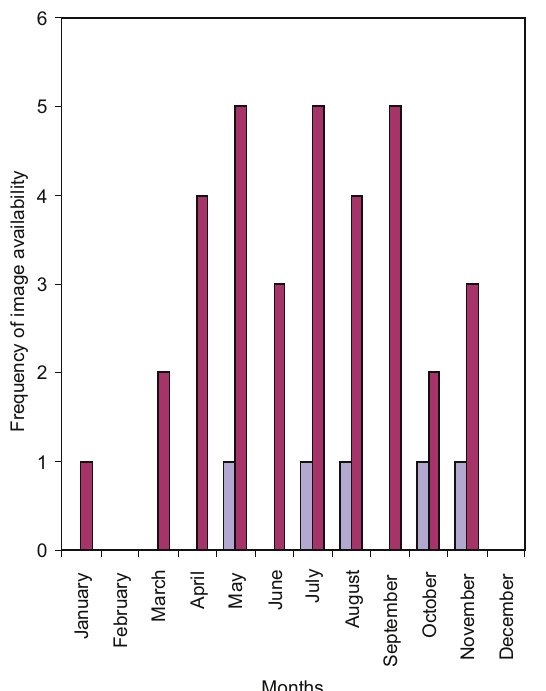
Fig. 10. Frequency of numbers of total and cloud-free image availability in Charter’s